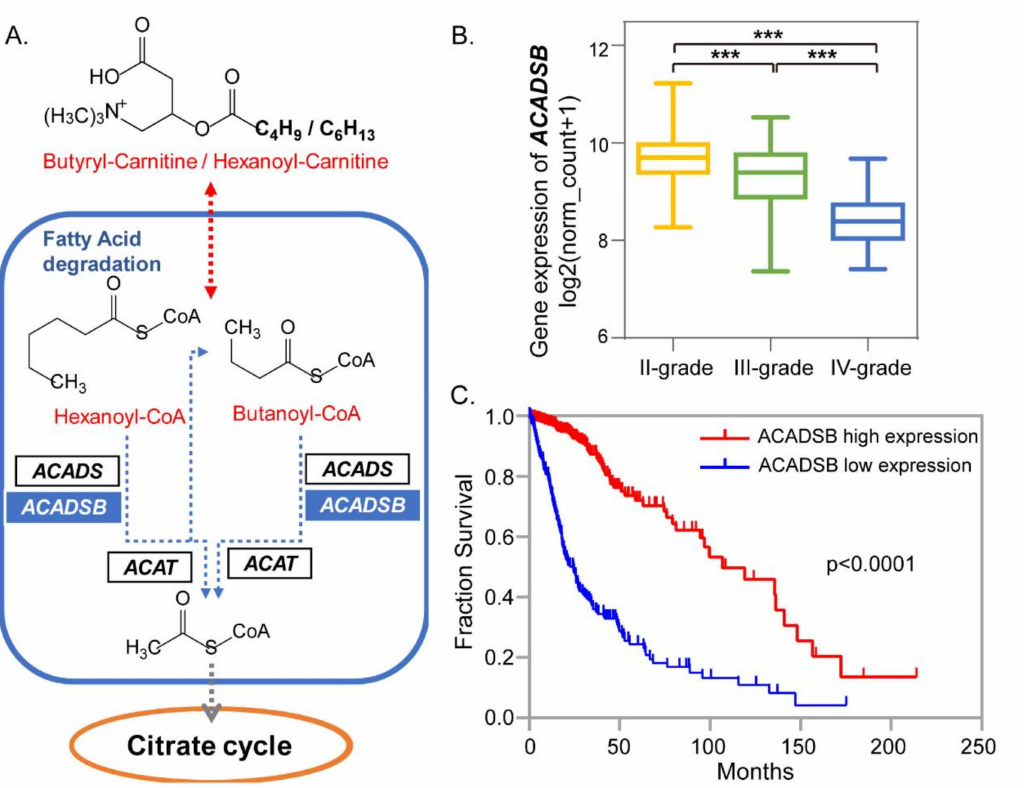
Figure 5. Short-chain acylcarnitine (C4-CN and C6-CN)-related changes for di ff erent grades of gliomas. ( A ) Degradation of short-chain acylcarnitines (in the form of acyl-CoAs) catalyzed by short / branched-chain acyl-coenzyme dehydrogenase (ACADSB) during fatty acid beta-oxidation. Red fonts represent up-regulation, and blue fonts represent down-regulation in high-grade gliomas. ( B ) The gene expression of ACADSB in di ff erent grades of glioma tissues according to TCGA database. ( C ) Kaplan–Meier analysis of patients having higher or lower ACADSB expression levels based on TCGA database. Significance level, *** p <